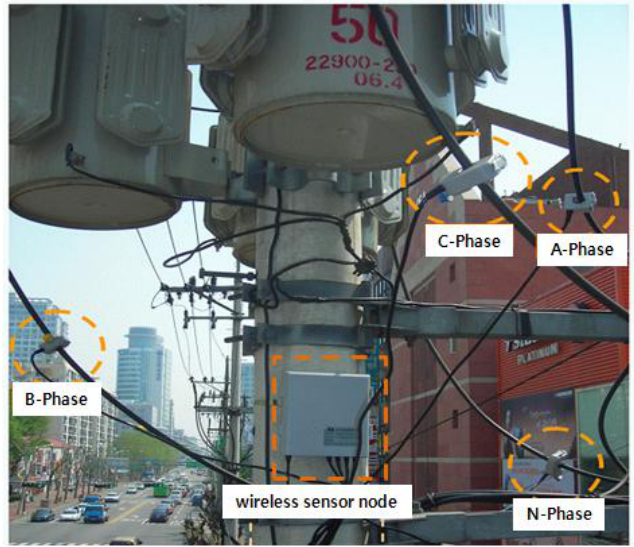
Figure 3. Wireless sensor node design on a pole